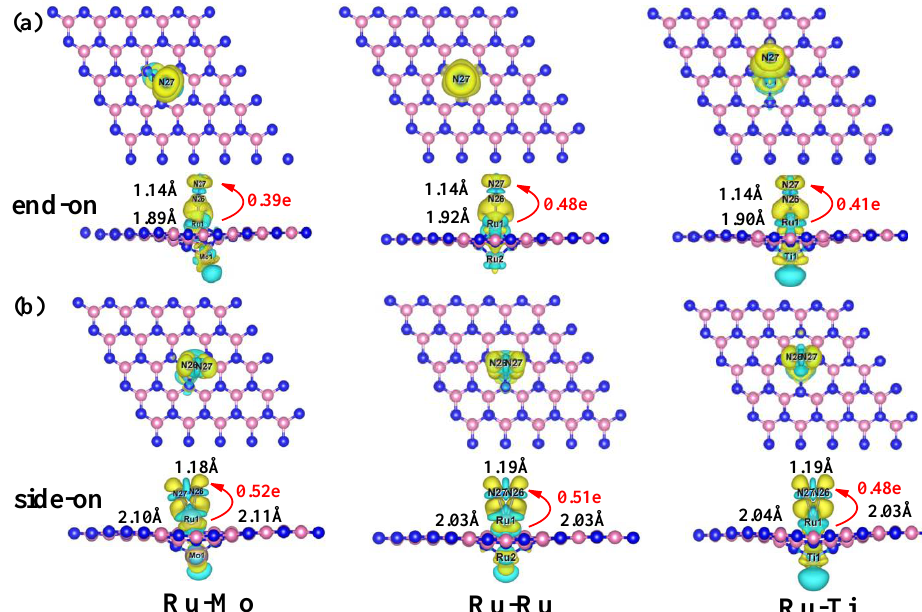
Figure 3. Optimized structures and change density differences of *N 2 on Ru-Mo@V B -BN, Ru-Ru@V B - BN and Ru-Ti@V B -BN catalysts for ( a ) end-on and ( b ) side-on configurations. The key bond lengths are also given.